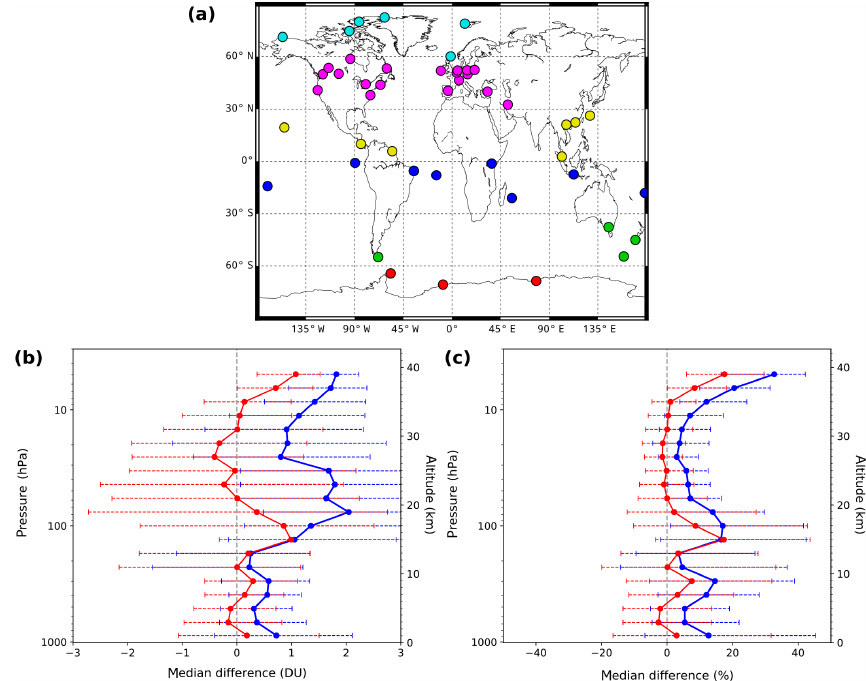
Figure 3. TM5 validation results with respect to sondes. Panel (a) shows the locations of all sondes used in the validation of the model. The colour coding of the sondes is the same as in Fig. 5. Panel (b) : median absolute difference; (c) : median relative difference. The blue line is the model run without assimilation; the red line is the model run with assimilation of GOME-2 and OMI. The error bars indicate the range between the 25th and 75th